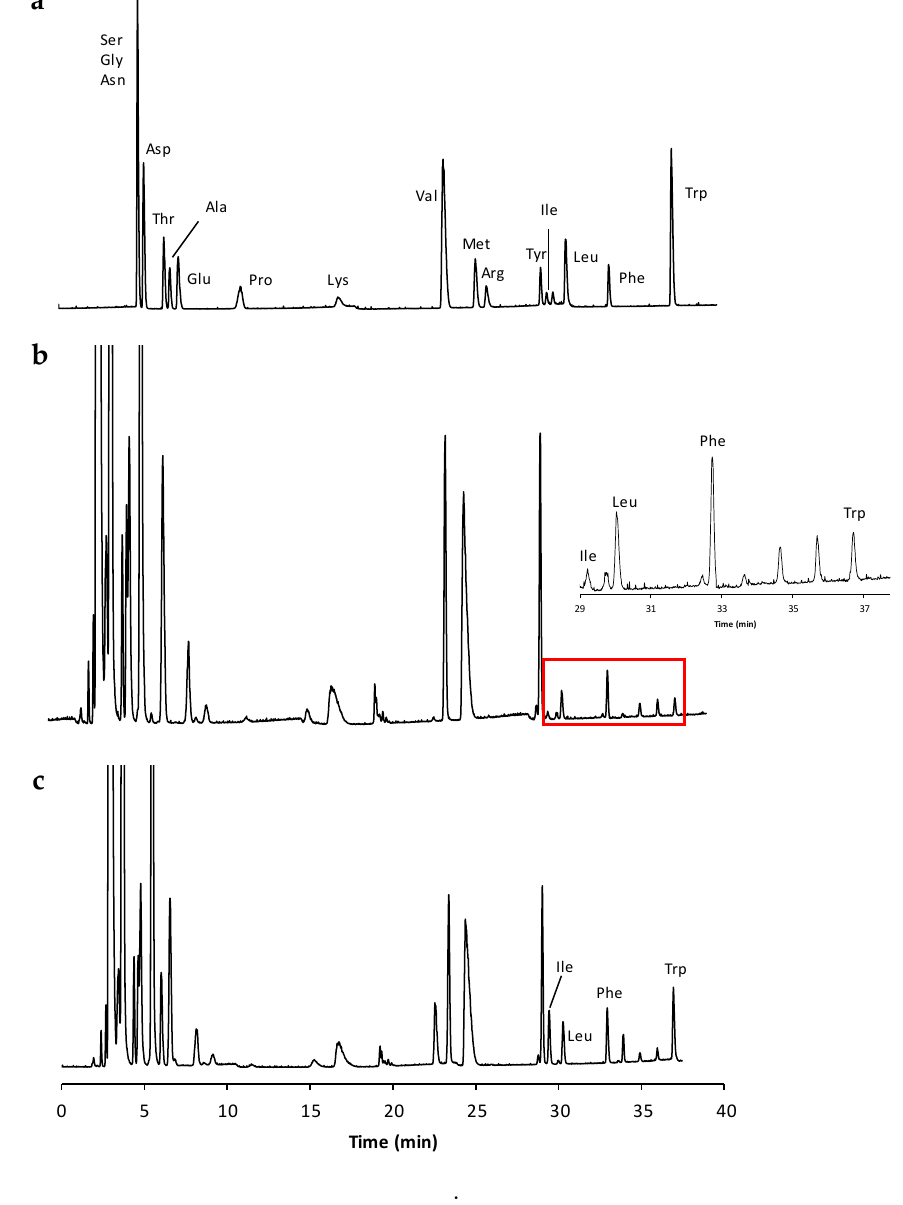
Figure 1. The chromatogram of ( a ) a standard amino acid mixture; ( b ) an extracted sample; and ( c ) a real sample spiked with a standard amino acid mixture. The enlarged section of the chromatogram in the time-window containing the three amino acids Leu, Phe, and Trp is highlighted. The Y-axis is in the mV scale.